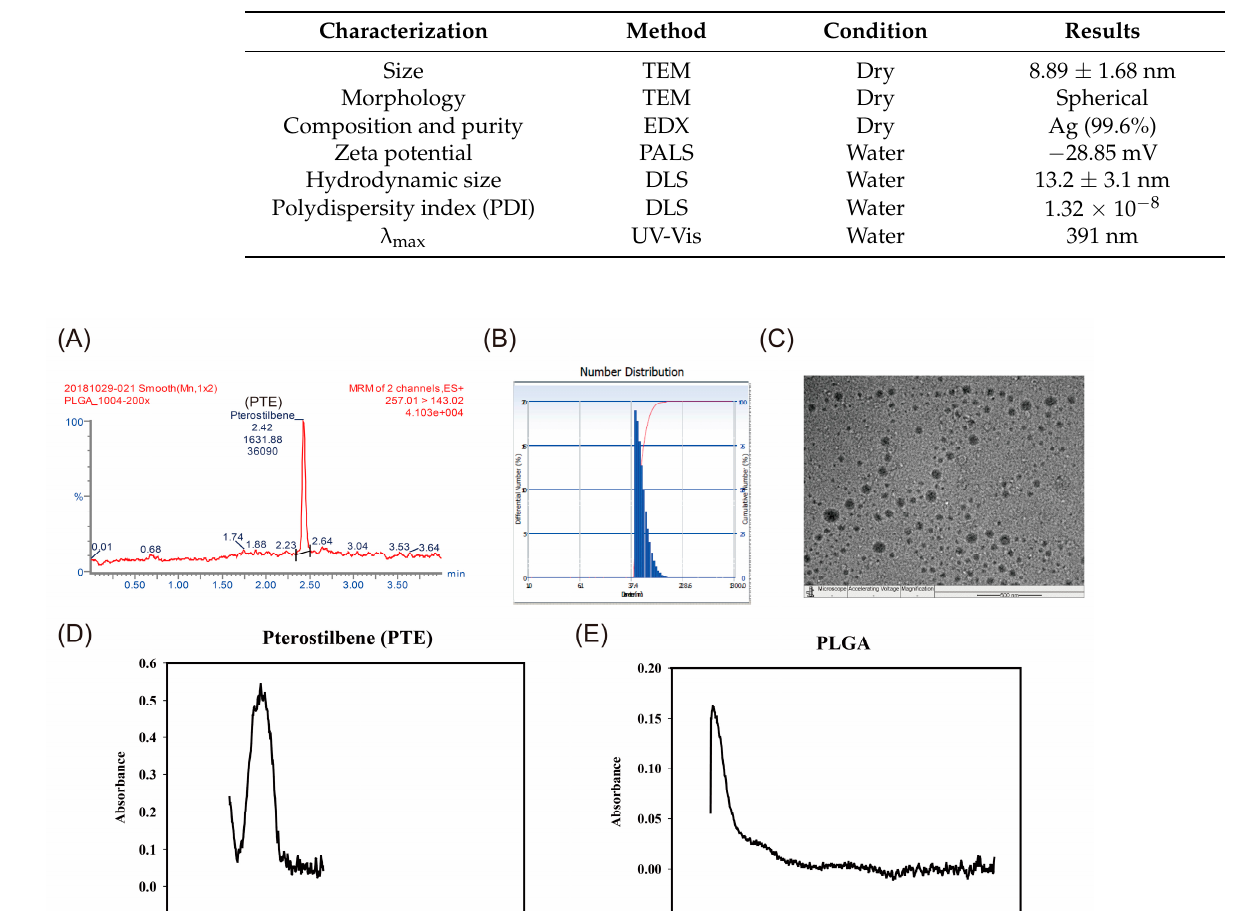
Table 1. Characterization of AgNPs.